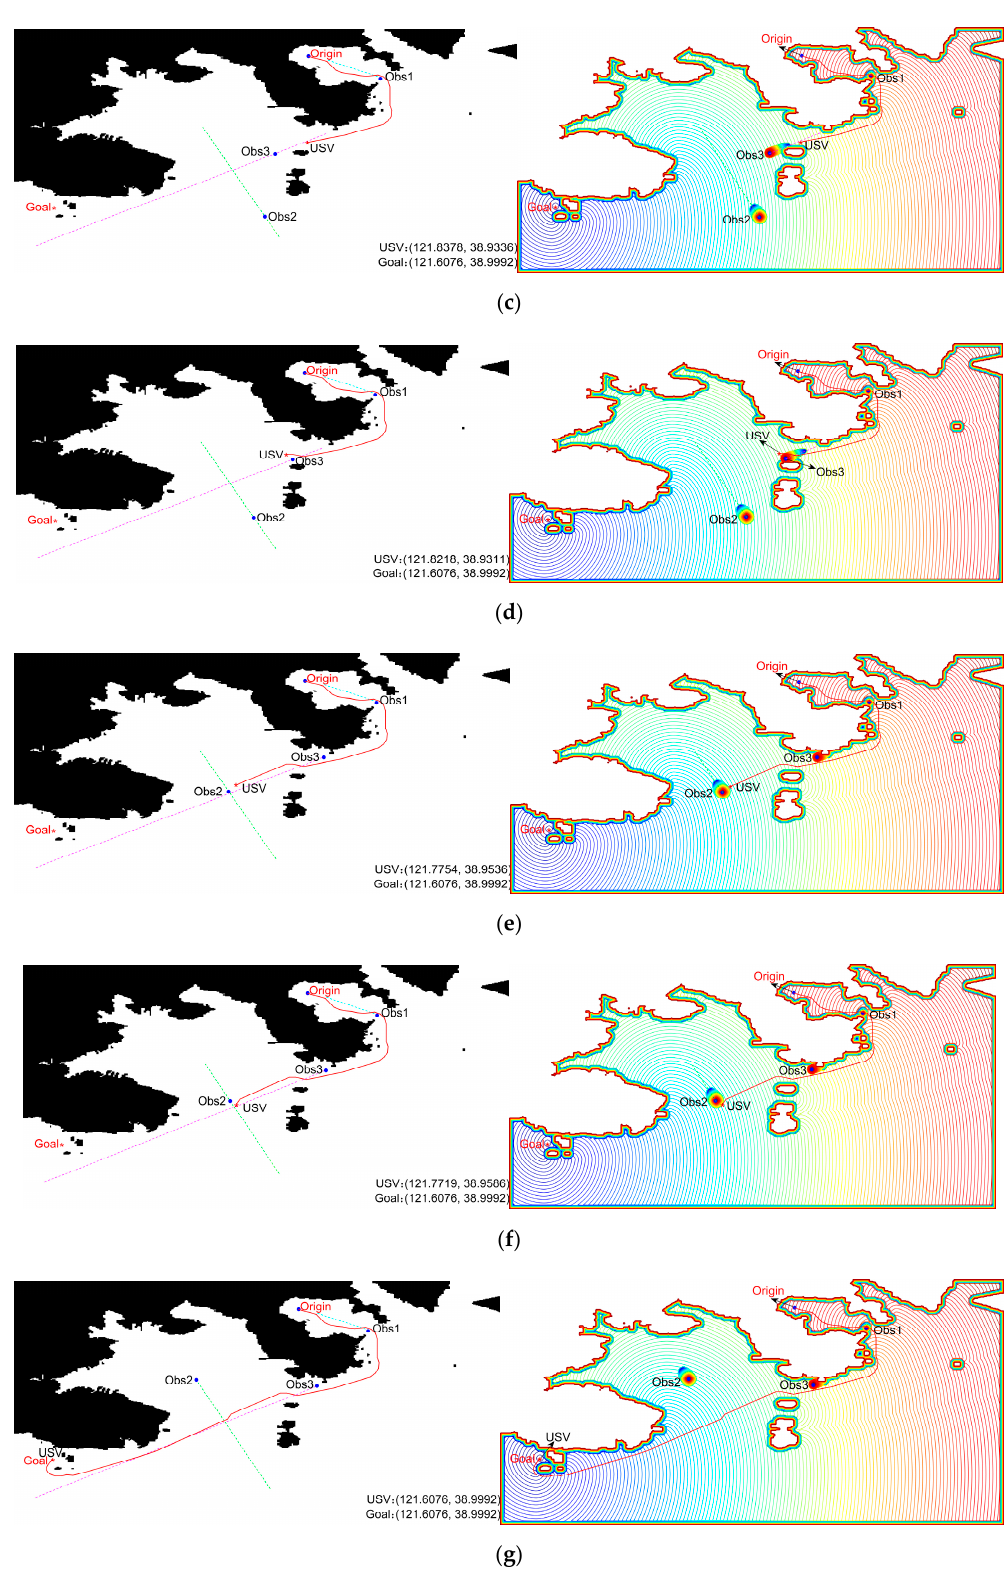
Figure 28. Trajectory map and corresponding potential field map of USV mission planning: ( a ) simulation cycle 6; ( b ) simulation cycle 13; ( c ) simulation cycle 35 ( d ) simulation cycle 38; ( e ) simulation cycle 47; ( f ) simulation cycle 48; ( g ) simulation cycle